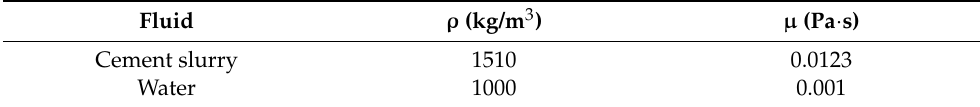
Figure 6. Sand porosity contour. Table 2. Slurry and water parameters in FLUENT.